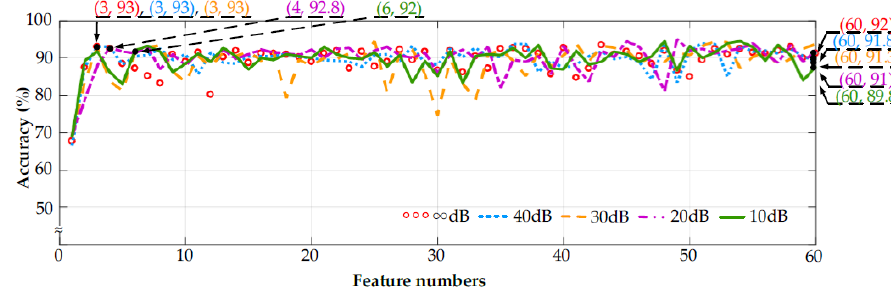
Figure 13. Accuracy curves of the HHT–CFS.